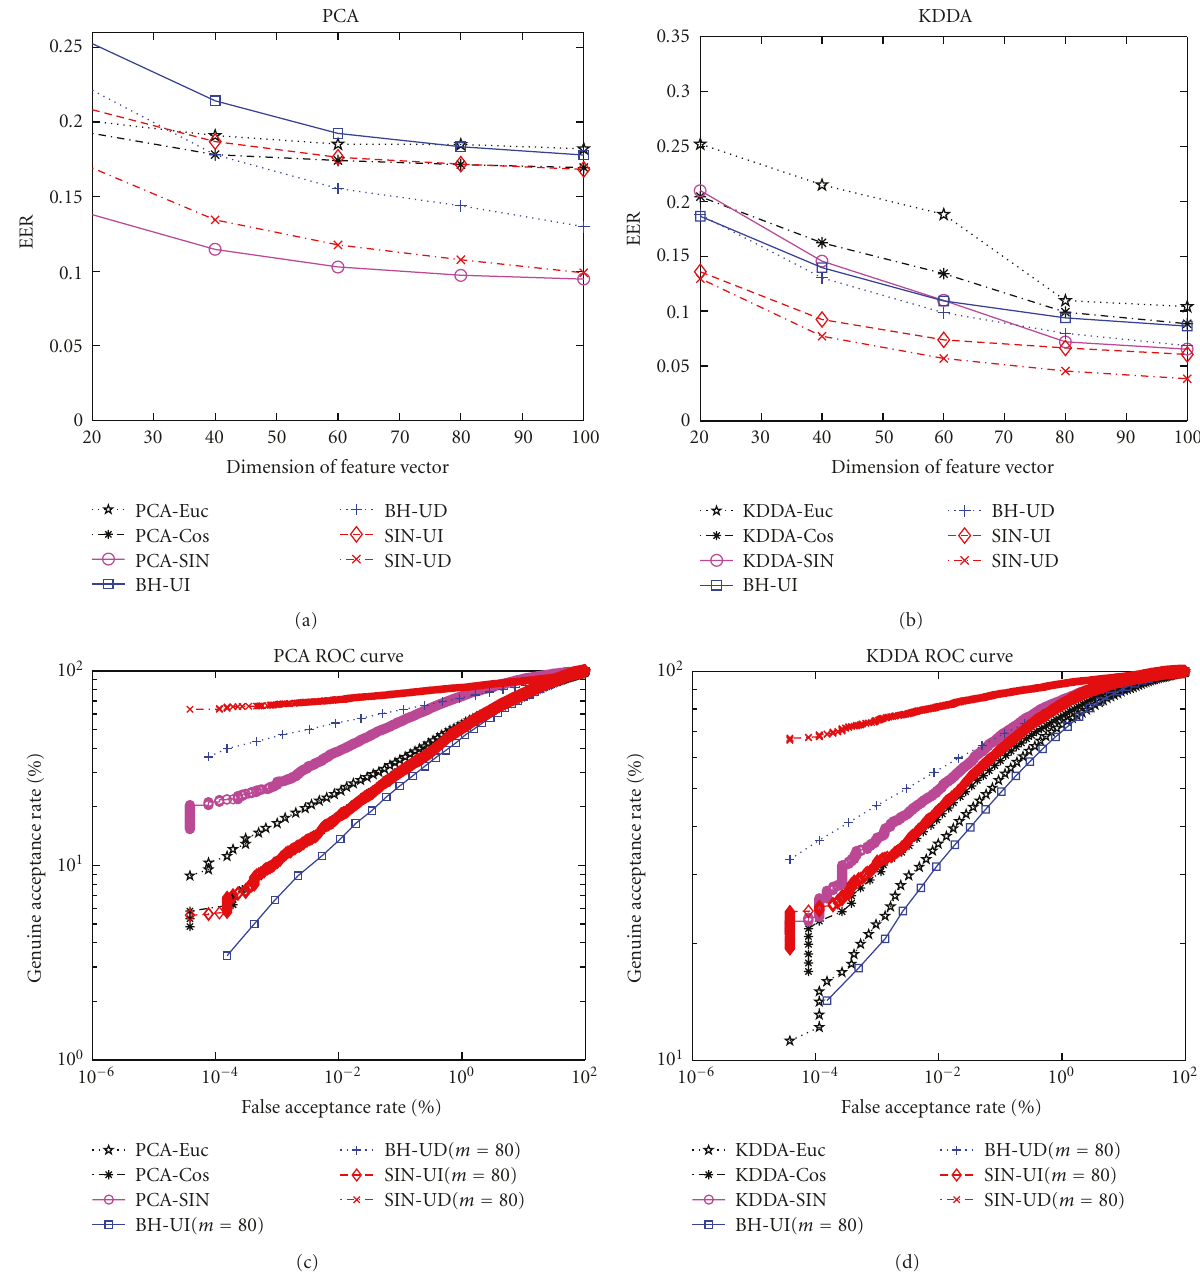
Figure 9: Obtained EER and ROC plots for PCA and KDDA (UI: user-independent, UD: user-dependent).